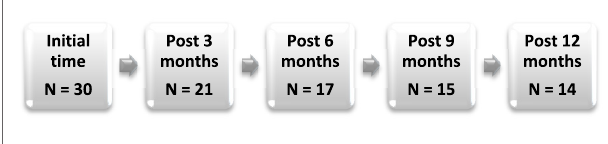
FigUre 2 | illustration of initial recruitment and the following attritions .